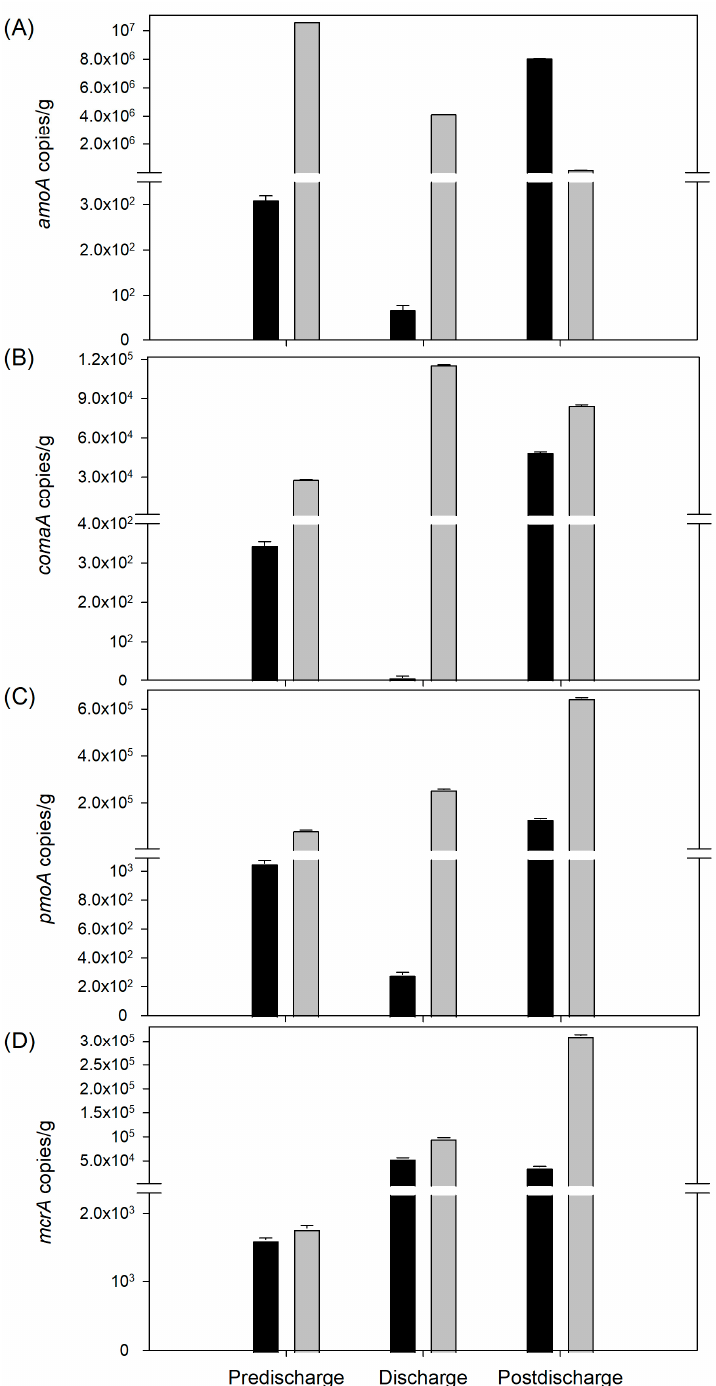
Figure 12. Abundance of all targeted functional genes ( A ) amoA, ( B ) commaA, ( C ) pmoA, and ( D ) mrcA ) in the predischarge, discharge, and post-discharge stations during winter (black bars) and summer (grey bars). The abundance is expressed in copies per gram of sediment dry weight (DW). Spearman multiple correlation analysis was carried out to evaluate the relationships between the functional groups abundance based on qPCR and the contribution of func- tional microbial groups composition by 16S rDNA sequencing. The mcrA gene abundance (i.e., in copies/g sediment DW) showed a positive correlation between several taxa of methanogens, including counts belonging to Methanomassilicoccaceae, Methanosaetaceae, Methanoregulaceae correlated with Methanospirillaceae, Methanofastidiosaceae, and